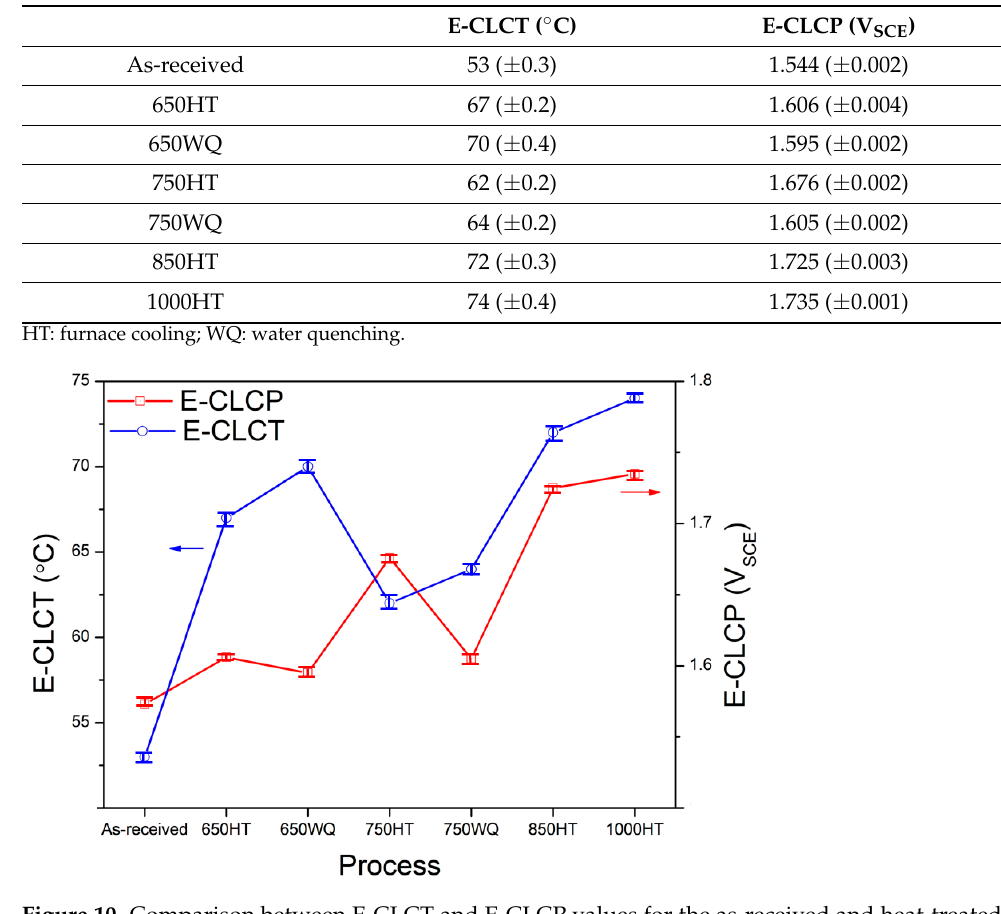
Figure 9. Determination of the E-CLCT values for the as-received and heat-treated AM Ti–6Al–4V alloys at various temperatures and cooling methods according to the applied potentials of 2.8 V SCE in a concentrated NaCl (25 wt%) solution (HT: furnace cooling; WQ: water quenching). Table 2. Values of E-CLCT and E-CLCP of the as-received and heat-treated AM Ti–6Al–4V alloys in various heat-treated temperatures.